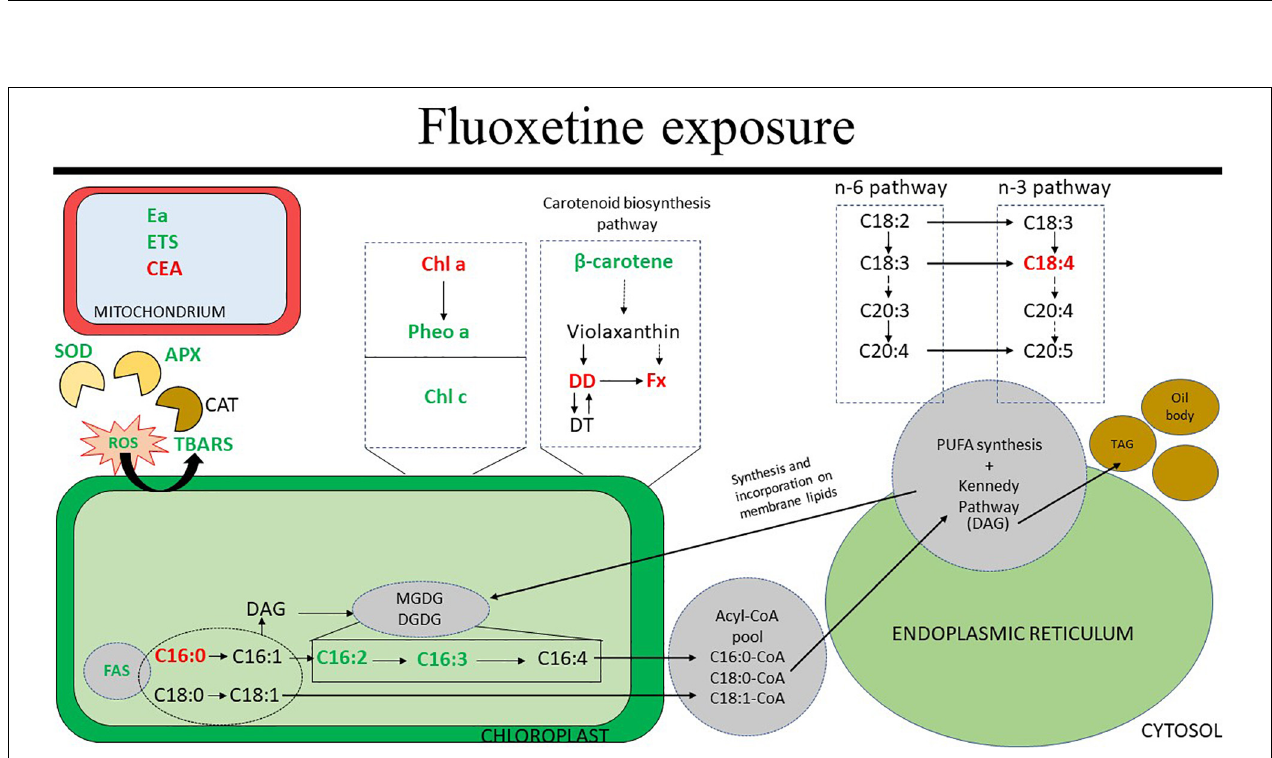
FIGURE 10 | Schematic representation of the physiological effects reported in this study related to fluoxetine exposure of Phaeodactylum tricornutum cells for 48 h. The results shown are related to the highest fluoxetine concentration (80 µ g L − 1 ). Arrows represent simplified (dashed) and direct (full) pathways. Green and red correspond to increased and decreased abundance, respectively. Abbreviations include: APX, ascorbate peroxidase; CAT, catalase; CEA, cellular energy allocation; Chl a , chlorophyll a ; Chl c , chlorophyll c ; DAG, diacylglycerol; DD, diadinoxanthin; DGDG, digalactosyldiacylglycerol; DT, diatoxanthin; Ea, available energy; ETS, mitochondrial electron transport system; FAS, fatty acid synthesis; Fx, fucoxanthin; MGDG, monogalactosyldiacylglycerol; Pheo a , pheophytin a ; PUFA, polyunsaturated fatty acids; ROS, reactive oxygen species; SOD, superoxide dismutase; TAG, triacylglycerol; TBARS, thiobarbituric acid reactive substances. Metabolic pathways addressed are overly simplified versions of the figures published by Kuczynska et al. (2015) and Mühlroth et al. (2013).